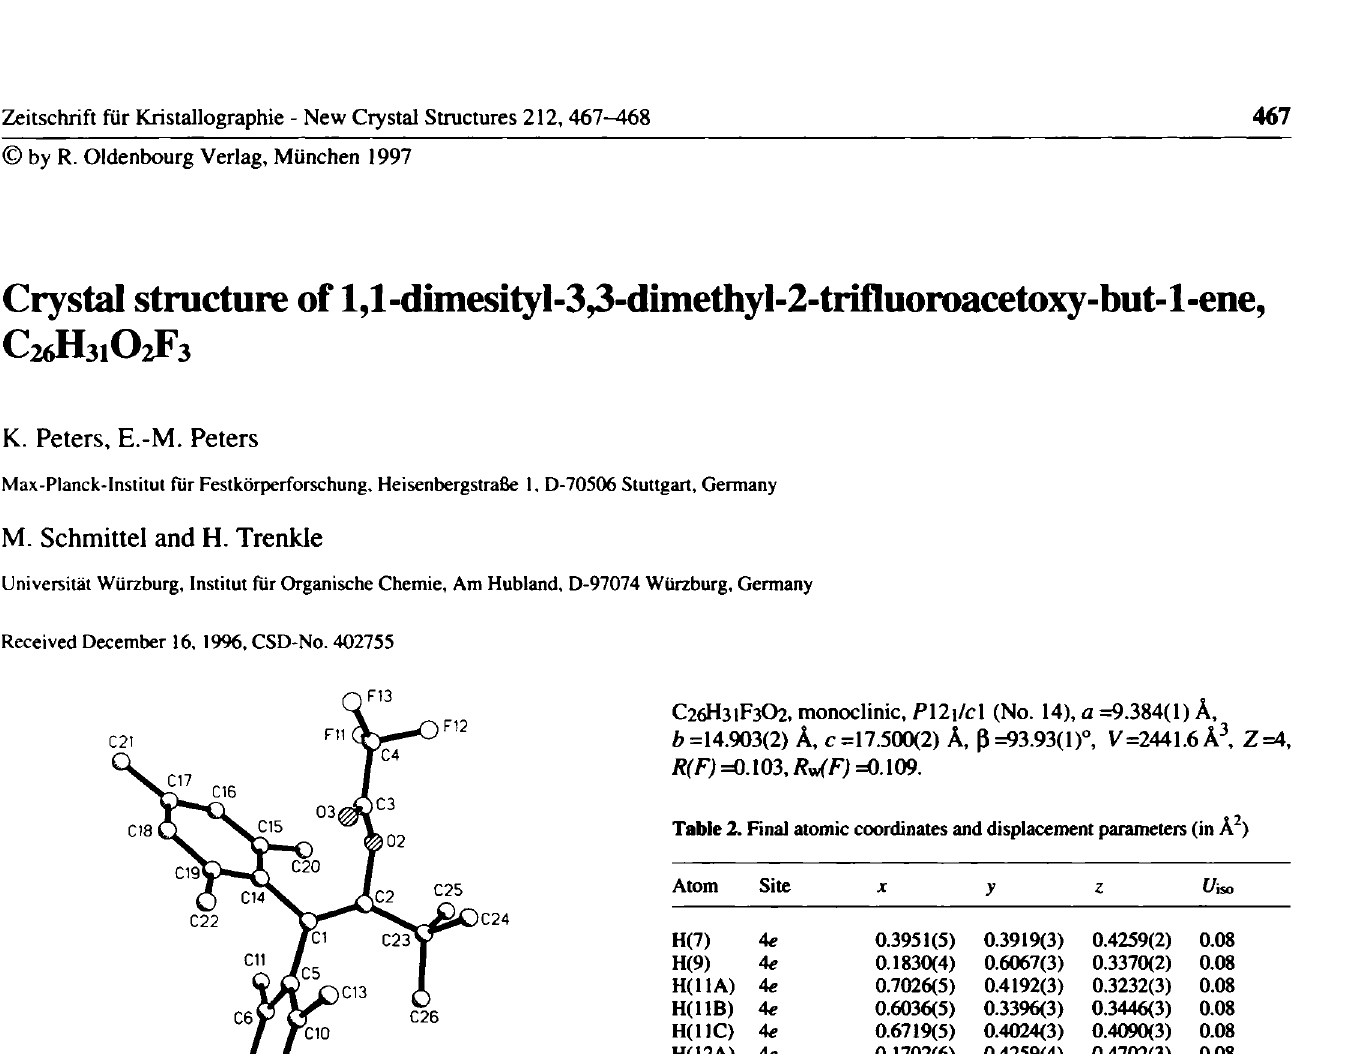
Table 2. Final atomic coordinates and displacement parameters (in A 2 )